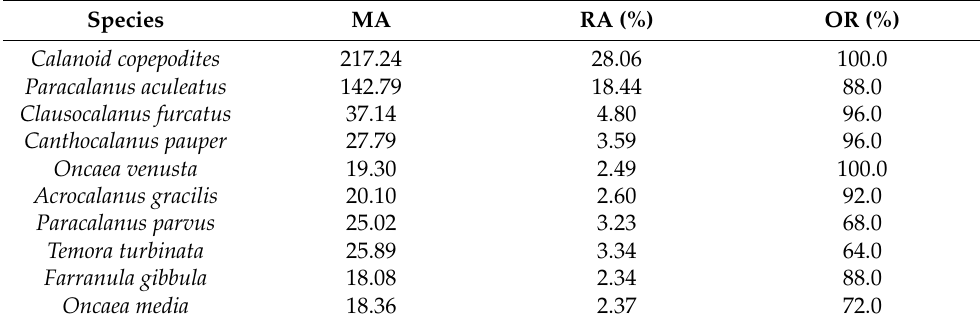
Figure 5. Horizontal distribution of copepod abundances in the study area. Table 1. Mean abundance (ind.m − 3 ), relative abundance (RA) and occurrence rate (OR) of dominant species in the research